Question: Express in one sentence what the figure is showing.
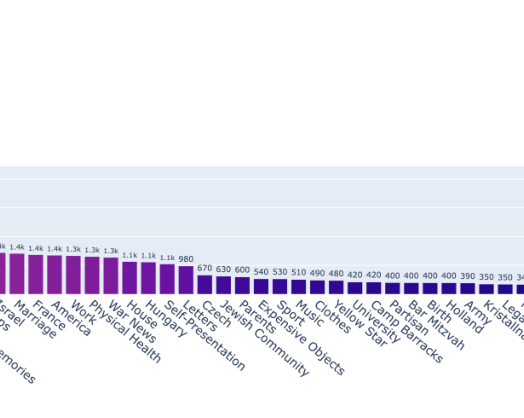
Answer: Corpus level QA-s topics histogram.